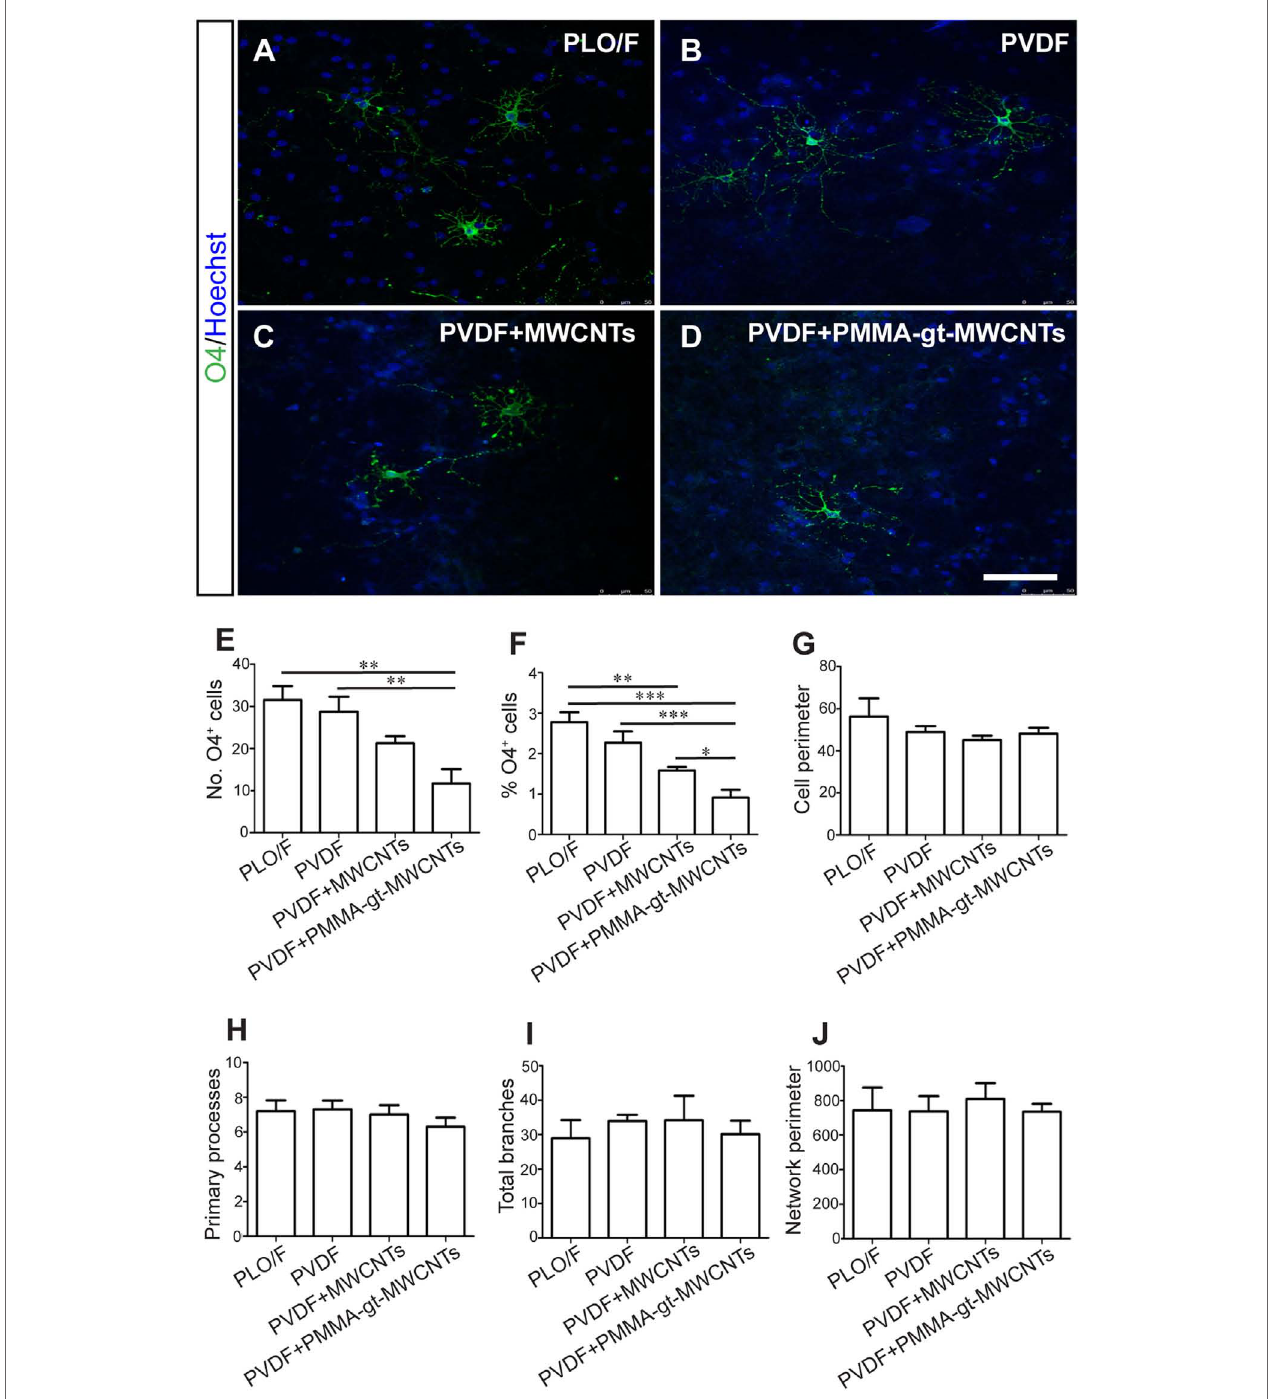
FigUre 9 | PVDF membranes do not support oligodendrocyte survival but are permissive for their morphological differentiation . The aOBSC neurospheres were dissociated and seeded on PLO/F, and PVDF, PVDF + MWCNTs, and PVDF + PMMA-gt-MWCNTs membranes for 7 days in a serum-containing and formed oligodendrocytes, which were detected by antibodies against O4 (a–D) . There were significant decreases in the number of O4 + oligodendrocytes when grown on PVDF + PMMA-gt-MWCNTs compared to PVDF and PLO/F (e) . For the percentage of oligodendrocytes (F) , there were significant decreases when cells were grown on PVDF + MWCNTs and PVDF + PMMA-gt-MWCNTs, compared to PLO/F and PVDF (F) . There were no significant differences in morphological parameters between conditions (g–J) . The graph bars represent the mean ± SEM ( n = 5–6 cultures per condition; n = 10 O4 + oligodendrocytes). Statistical analyses were performed using one-way ANOVA and Kruskal–Wallis tests and Tukey’s and Dunn’s tests as post hoc analysis, respectively. * P < 0.05, ** P < 0.01, *** P < 0.001. Scale bar [shown in (D) ] = 48.1 μ